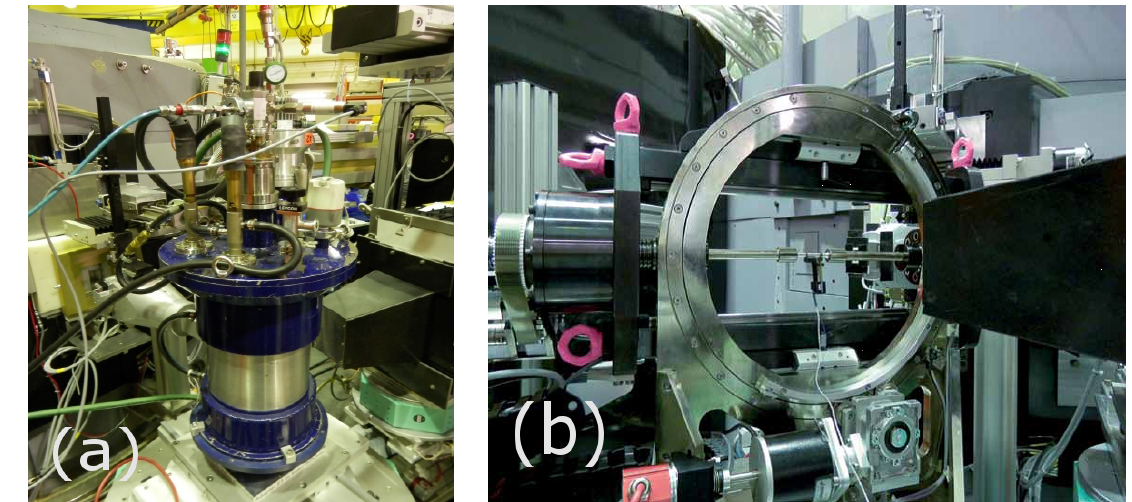
Figure 3: High-temperature furnace setup on E3 (a). A rotatable load frame for tensile and compressive testing